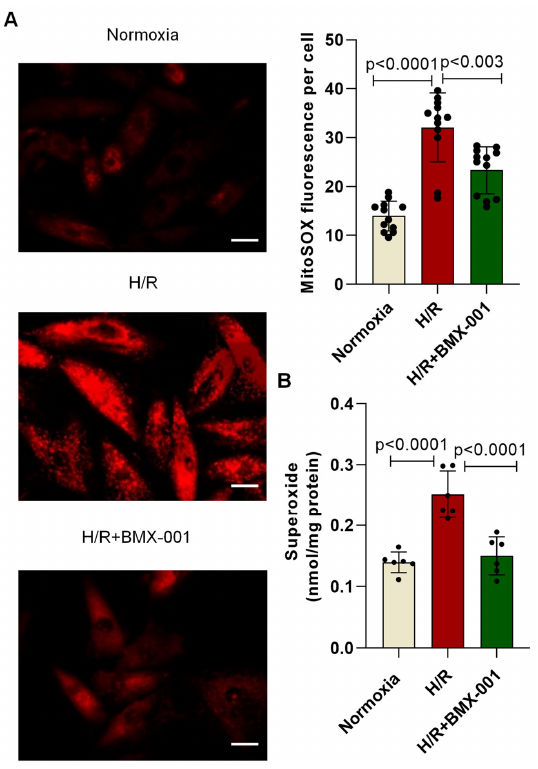
Figure 2. BMX-001 a tt enuated H/R-induced mitochondrial superoxide levels in H9c2 cells. ( A ) Mi- Figure 2. BMX-001 attenuated H/R-induced mitochondrial superoxide levels in H9c2 tochondrial superoxide level was determined by measuring the fl uorescence of MitoSOX in H9c2 cells (magni fi cation ×20). ( B ) Quanti fi cation of intracellular superoxide by HPLC. All values are mean ± SD. The p -value was used to determine statistical signi fi cance compared to the control group.